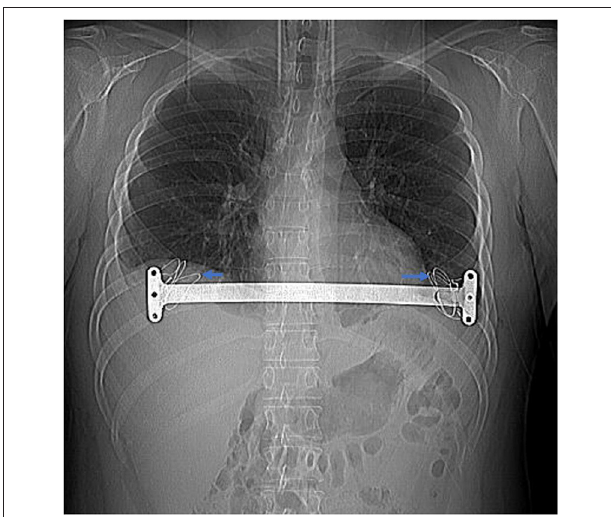
FIGURE 4 | Bilateral intercostal space was narrowed with steel wires when intercostal muscle tear (shown by the arrow) in a 24-year-old patient with recurrent pectus.